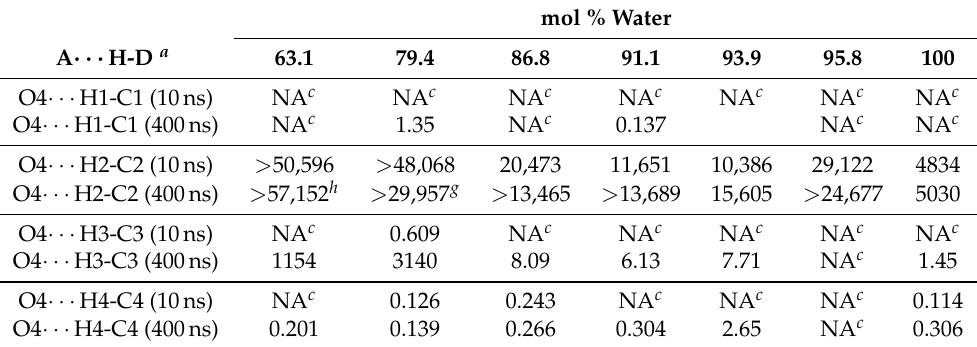
Table A3. TBPCl hydrogen bonding lifetimes (ps), Part 4 of